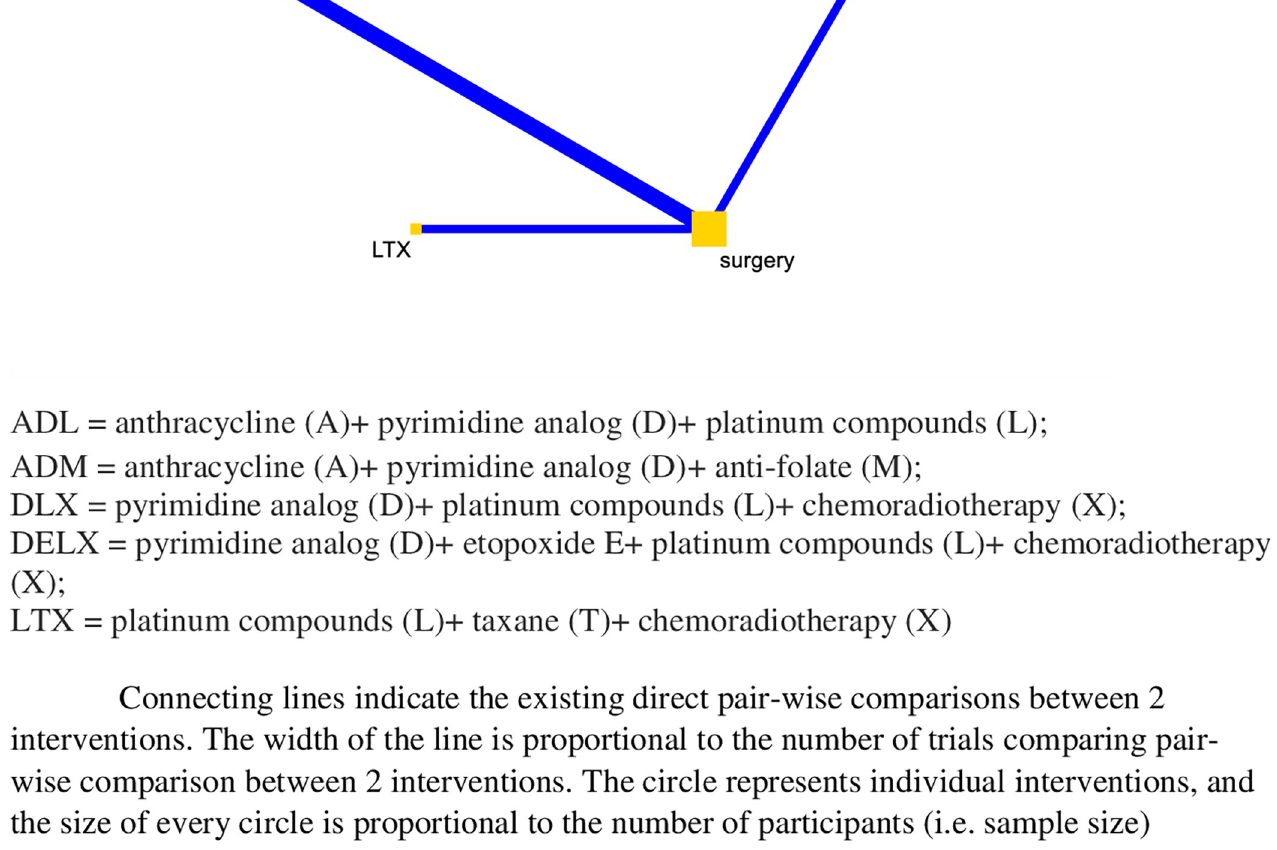
Fig 3. R0 resection network plot. 4. For the endpoint assessment of R0 resection rate, this network meta-analysis showed LTX (a combination of chemoradiotherapy, platinum compounds and taxane) was the best- favoured neoadjuvant chemotherapy regimen for management of gastroesophageal and gastric cancer patients compared to alternative neoadjuvant chemotherapy, or surgery alone.